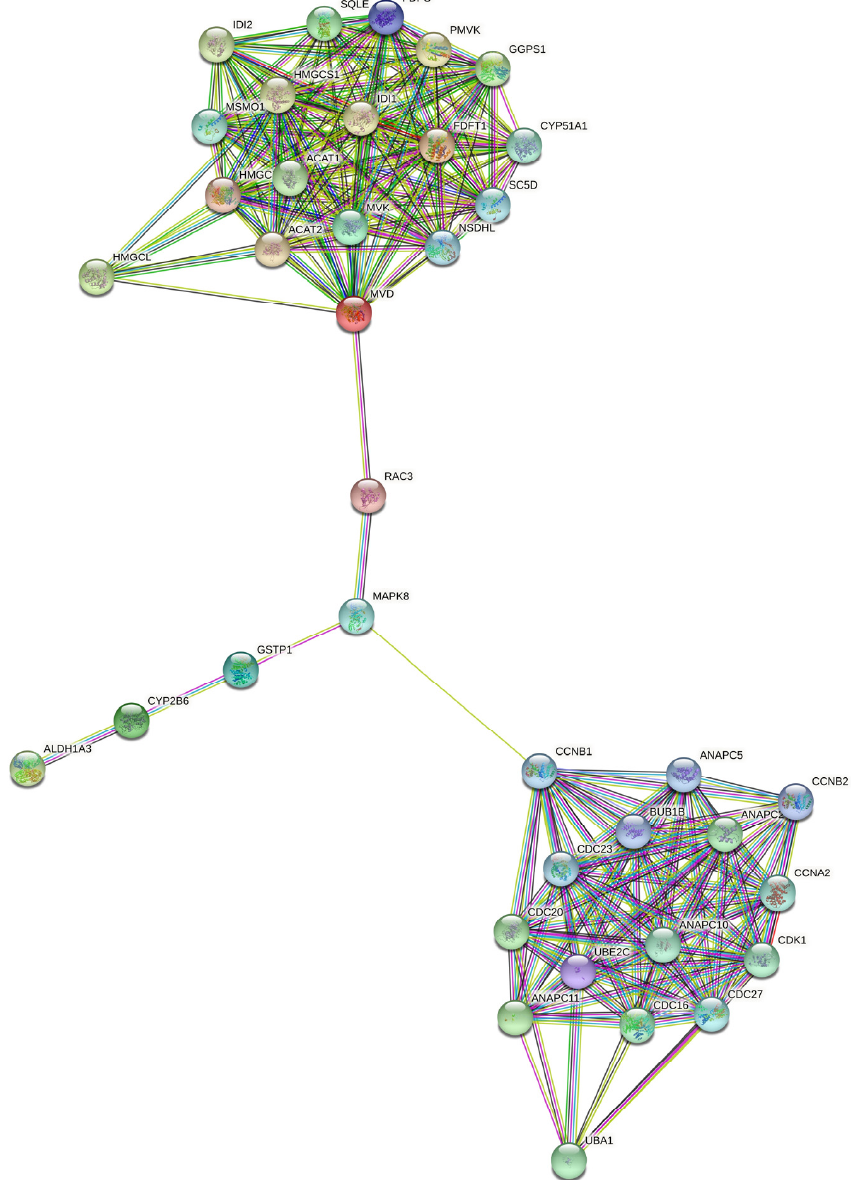
Figure 4. Network of interactions among mevalonate pathways and differentially expressed genes presented in the pathways obtained in Webgestalt by STRING software. Associations were visualized with a medium confidence cutoff (0.400).